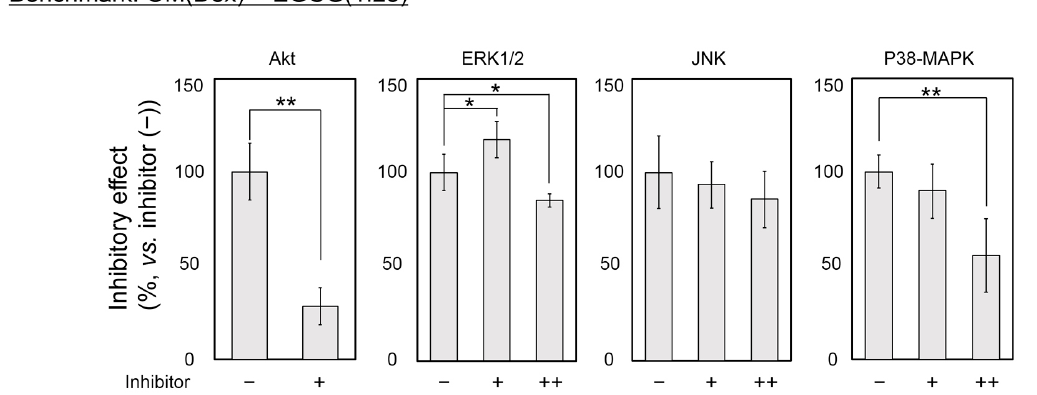
Figure 4. Effect of inhibitors of the extracellular signal-regulated kinase (ERK) 1/2, Akt, c-Jun N -terminal kinase (JNK) and p38-mitogen-activated protein kinase (MAPK) signaling pathways on EGCG-induced mineralization. Cells were seeded under condition 2. OM: osteogenic medium without Dex. OM(Dex): OM with 100 nM Dex. The cells were treated with or without inhibitors in OM + EGCG(1.25) or OM(Dex) + EGCG(1.25) for 12 days. N in EGCG(N): concentration of EGCG ( μ M). The concentrations of the inhibitors were designated as + and ++: 2.5 and 25 μ M for the ERK1/2 inhibitor PD98059; 1 and 10 μ M for the JNK inhibitor SP600125; and 1 and 10 μ M for the p38-MAPK inhibitor SB203580 (the Akt inhibitor API-2 was used at 1 μ M, designated as +). The alizarin red staining levels of the samples were normalized against those of the cells treated with OM + EGCG(1.25) or OM(Dex) + EGCG(1.25) without inhibitors. * p < 0.05, ** p < 0.01 (ANOVA with a